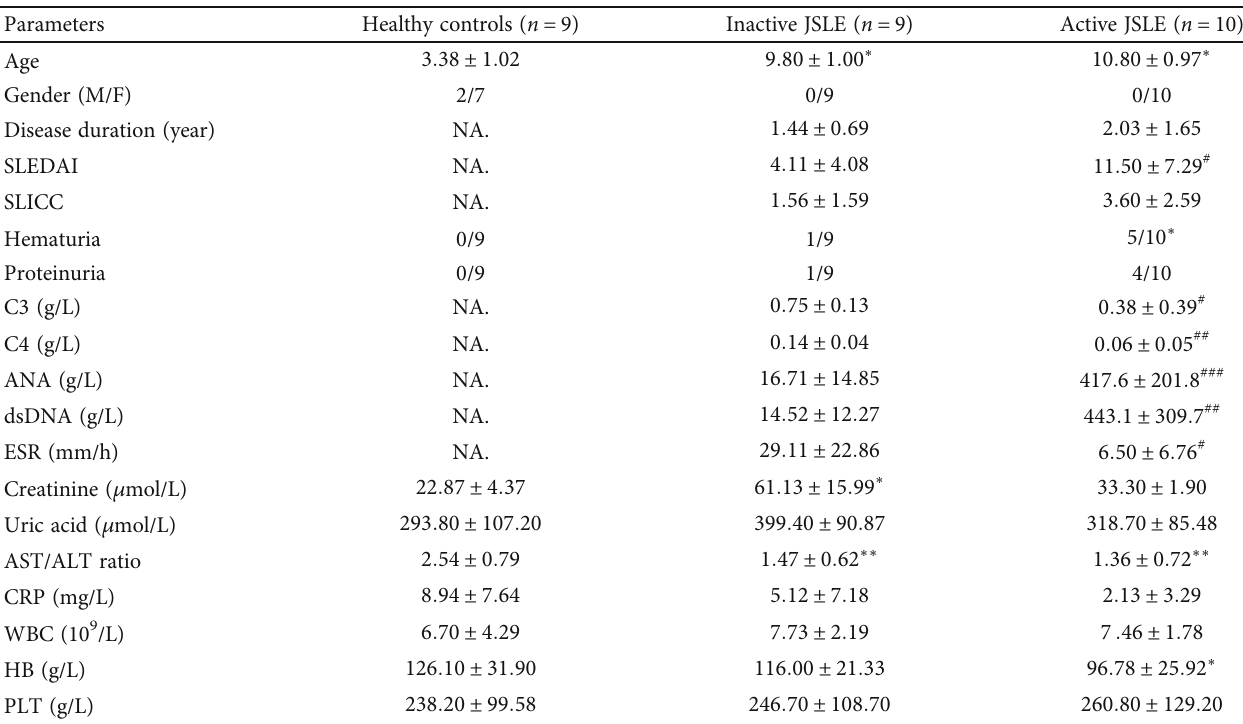
Table 1: Demography of clinical characteristics for JSLE patients and healthy controls ( mean ± SD ).